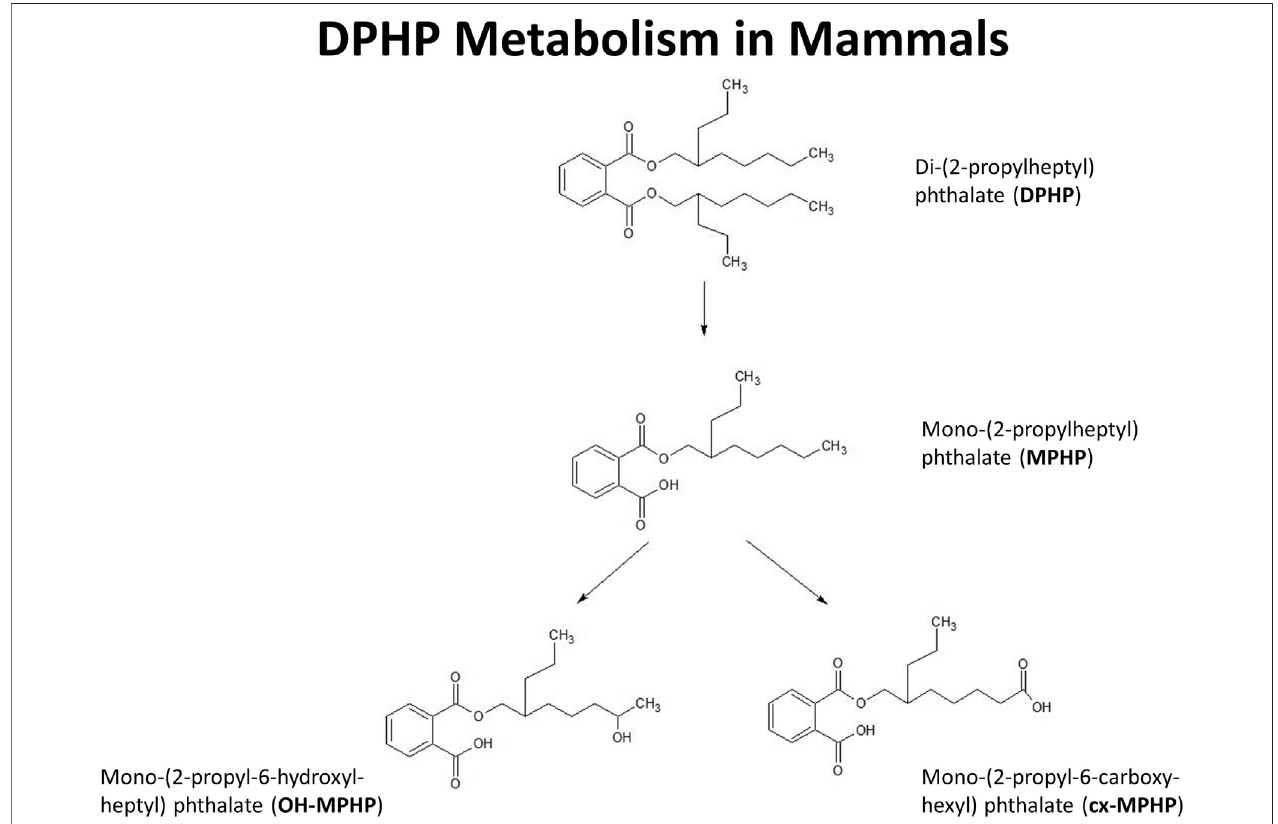
FIGURE 1 | Postulated metabolism of DPHP in humans showing only those metabolites measured in human biological monitoring and described in the PBPK model.